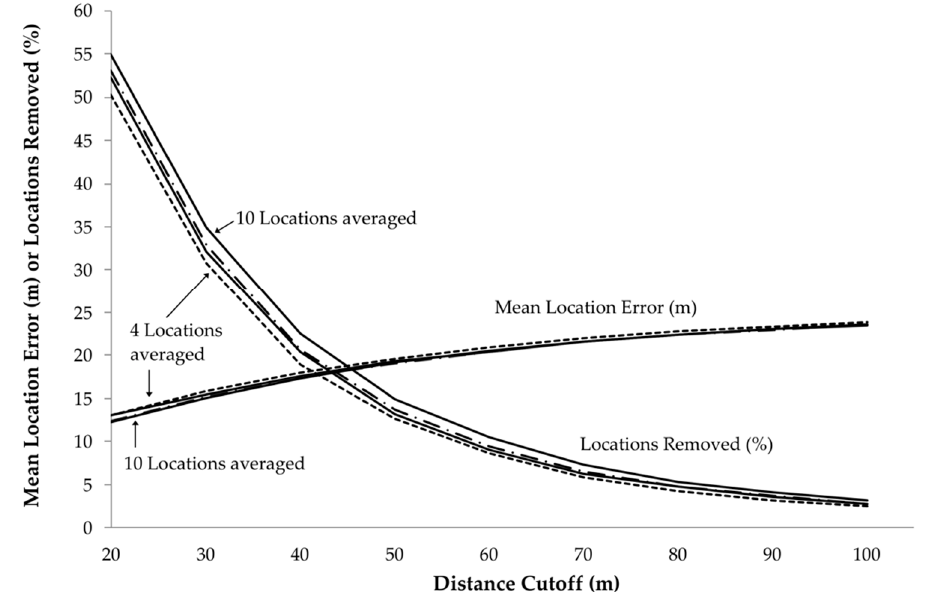
Figure 2. Sensitivity analysis for GPS outliers and number of adjacent locations used to calculate a moving average to screen stationary test GPS locations collected in summer 2015 and 2016 in northeastern Minnesota in commonly used wood turtle ( Glyptemys insculpta ) habitat. The graph includes the percent of GPS locations that would be screened and the corresponding mean location error for 20 to 100 m outlier thresholds calculated from a moving average of 4, 6, 8, or 10 adjacent GPS locations. Mean location error is the distance from the true location of the stationary GPS receiver.